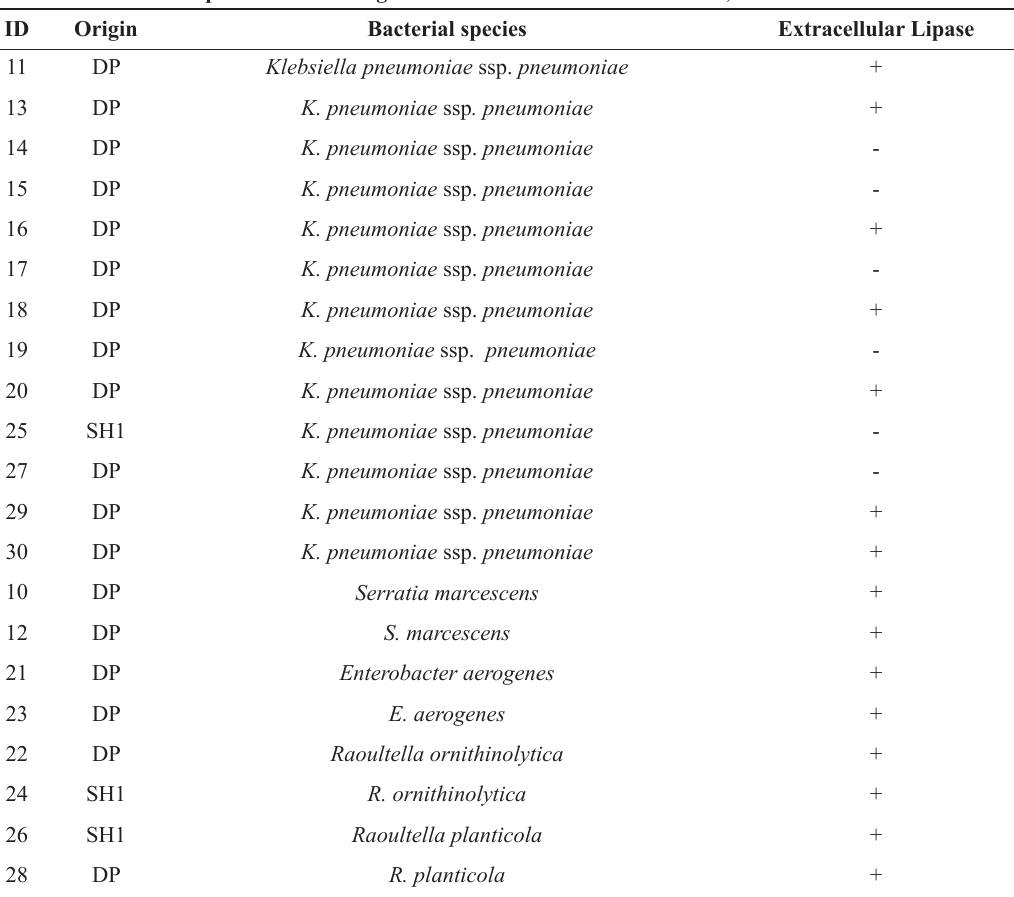
Origin, identification and extracellular lipase production from bacteria obtained from effluents of dairy products and slaughterhouses industries in Pelotas/rS, brazil. bacterial species Extracellular